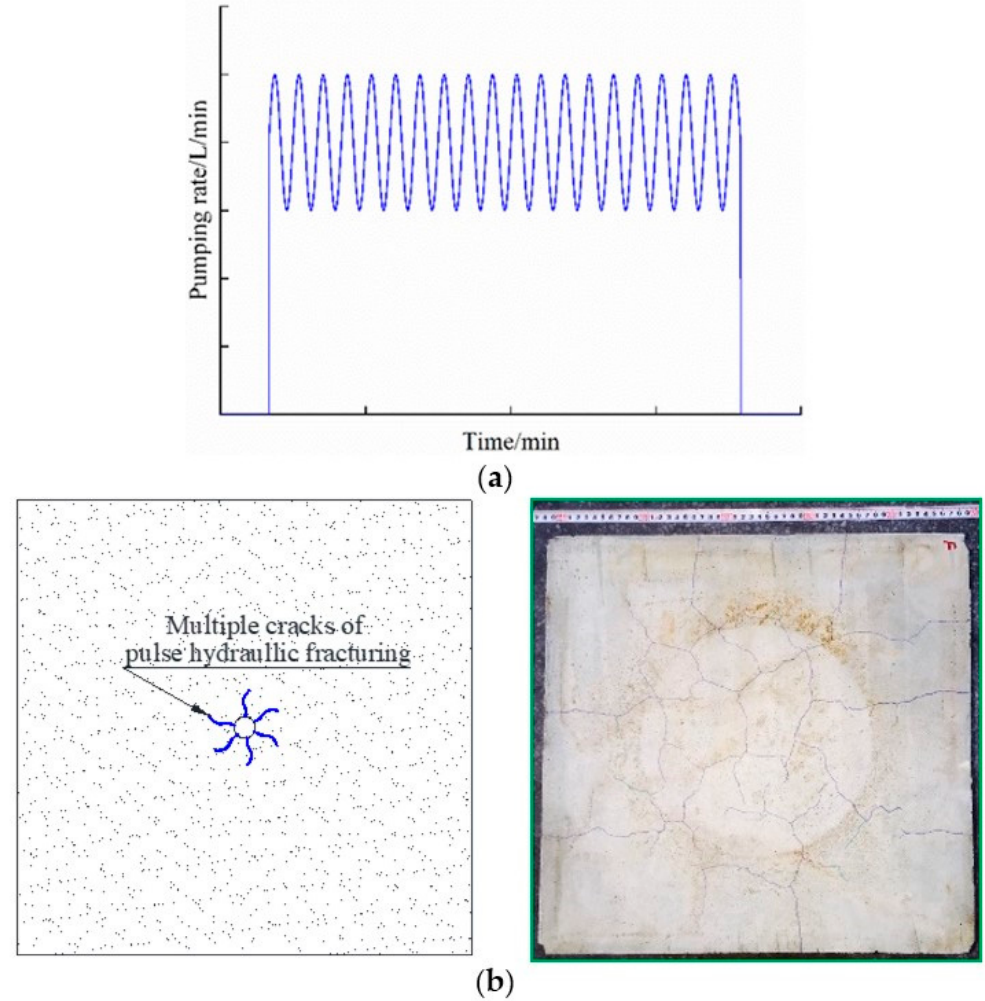
Figure 2. The hydraulic fracturing performed by pulse pumping rate: ( a ) pumping process and ( b ) hydraulic fracture